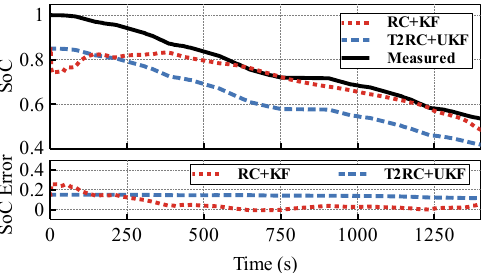
Figure 12. RC model with KF (RC+KF) and the 2 RC Thevenin model with UKF (T2RC+UKF) convergence test under wrong SoC initialization for the SLA battery.